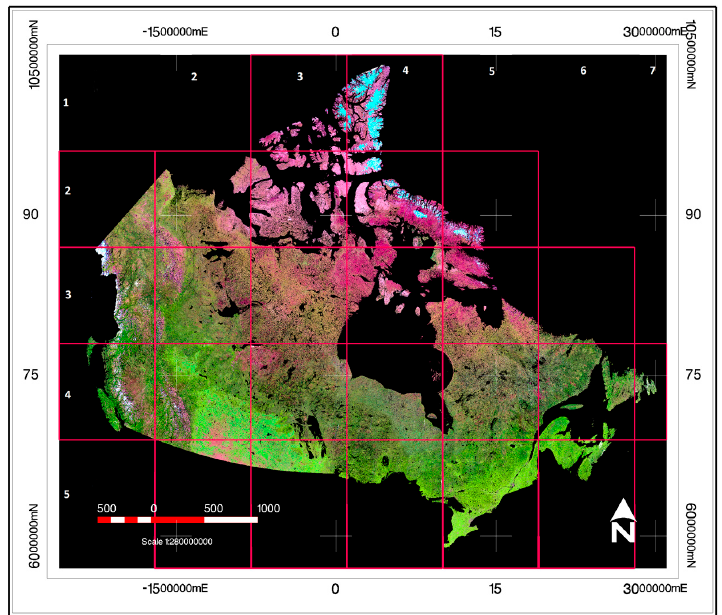
Figure 1. Landsat Mosaic of Canada 2010 false color composite Top of Atmosphere reflectance and tile system used for Landsat processing and land cover mapping.